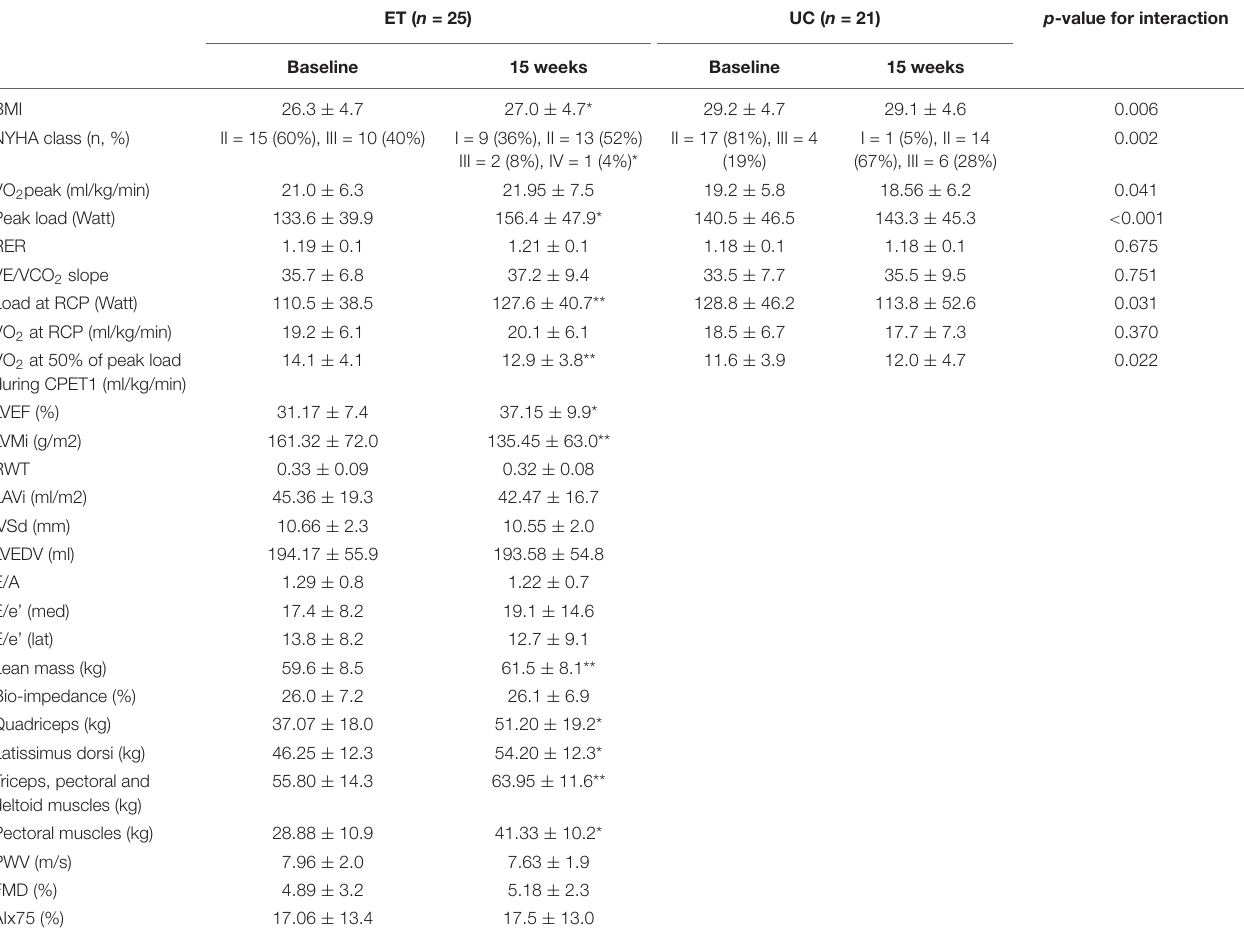
TABLE 2 | Change in clinical characteristics, CPET variables, echocardiographic findings, skeletal muscle strength, and vascular function after 15 weeks of either exercise training (ET) or usual care